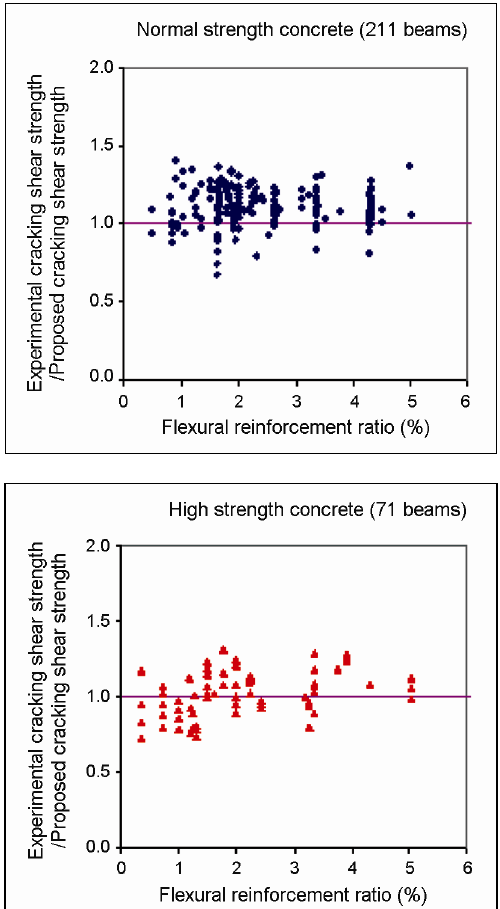
Fig. 6. Comparing experimental cracking shear strength values with proposed diagonal cracking strength of Eq. (12) for various compressive strength values equation, 58% of those obtained for ACI318 and TS500 predictions, 59% of those obtained for Collins’ and Khuntia’s equations, 66% of those obtained for Rebeiz’s and Zsutty’s equations, 74% of those obtained for EN prediction, 80% of that obtained for Kim’s equation, 83% of that obtained for CEB-FIP prediction and 88% of that obtained for Okamura’s equation. The resulting COV of the ratio of the experimental value (NSC and HSC) to the prediction from the pro- posed equation is 29% of those obtained for CSA Code prediction, 42% of those obtained for NZS Code predic- tion, 49% of those obtained for ACI318 and TS500 Code predictions, 51% of those obtained for Collins’ equation, 62% of those obtained for Bazant’s equation, 68% of those obtained for Rebeiz’s equation, 69% of those ob- tained for Zsutty’s equation, 75% of those obtained for EN prediction, 81% of that obtained for Kim’s equation, 83% of that obtained for CEB-FIP prediction and 88% of that obtained for Okamura’s